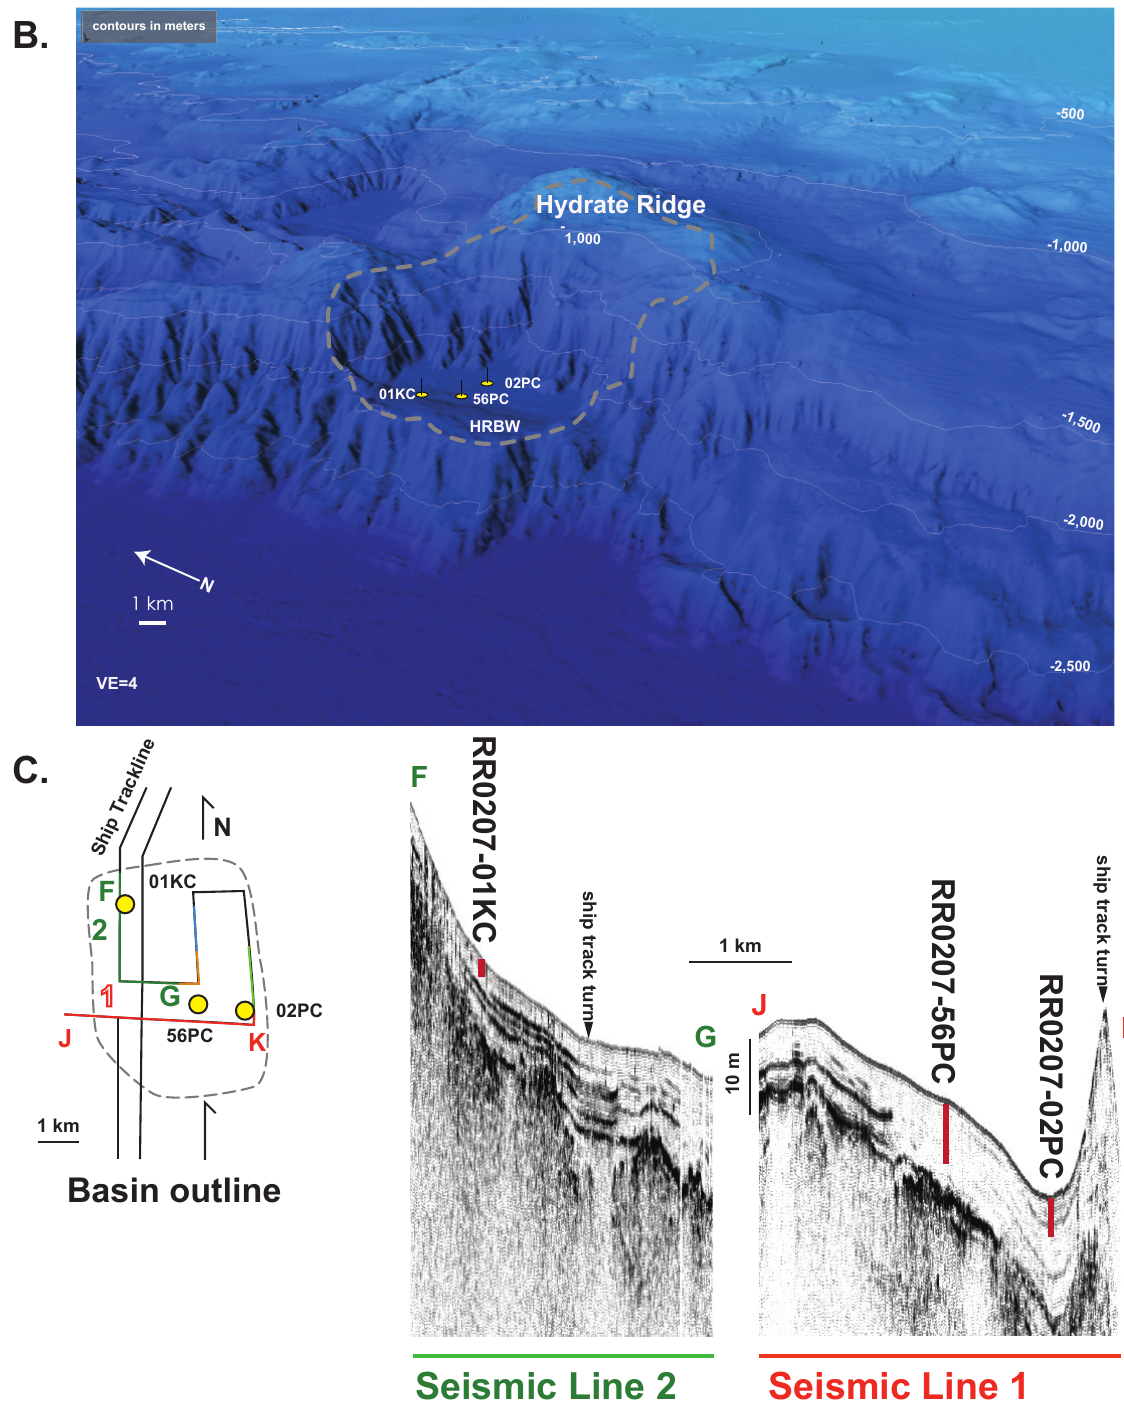
Fig. 7. (B) Low angle oblique view of core sites. (C) 3.5kHz seismic data collected during transit for our coring cruise TN0909 are processed with Sioseis and the envelope is plotted in Seisee. Inset map: Track lines associated with seismic data are plotted with colors that match the seismic data. Core location is designated by a red line scaled to core length. Cores are plotted in yellow and basin is outlined as dashed grey